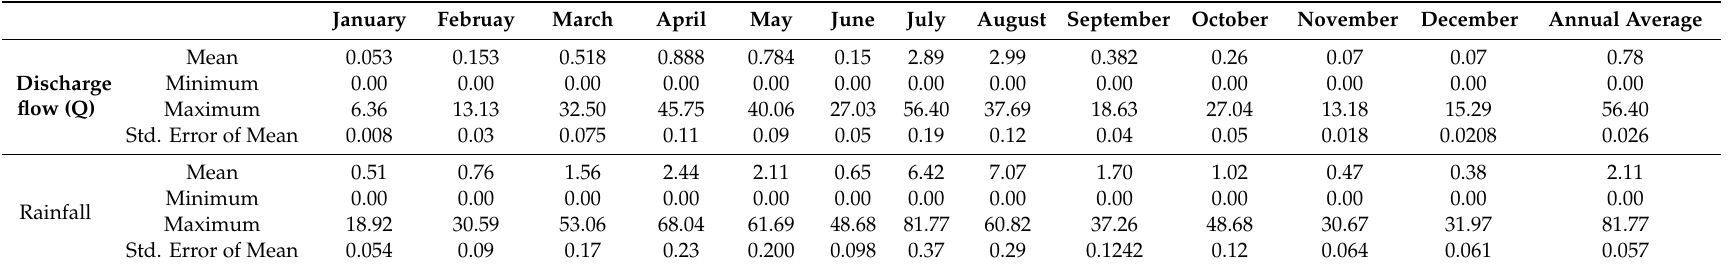
Table 8. Characteristics of monthly and annual rainfall P and stream discharge flow (Q) in Hugumburda Grat Kahisu state forest Northern, Ethiopia